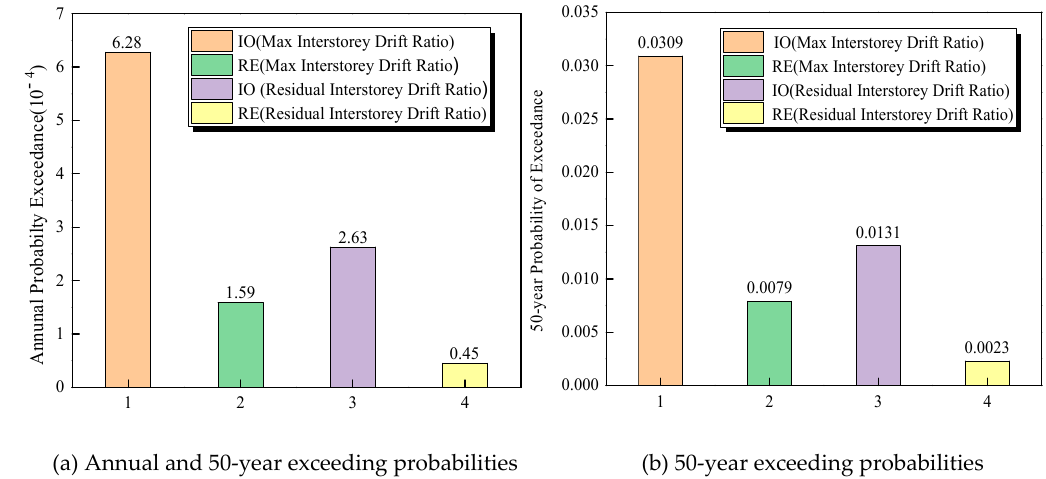
Figure 22. Annual and 50-year exceeding probabilities of novel SCPC frame under near-fault earthquake waves.